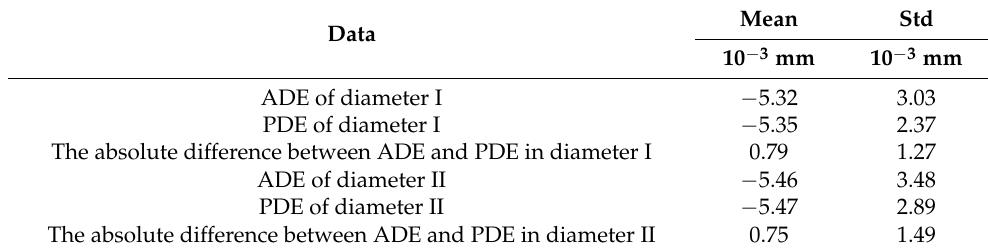
Table 8. The comparison between the actual dimension error (ADE) and the predicted dimension error